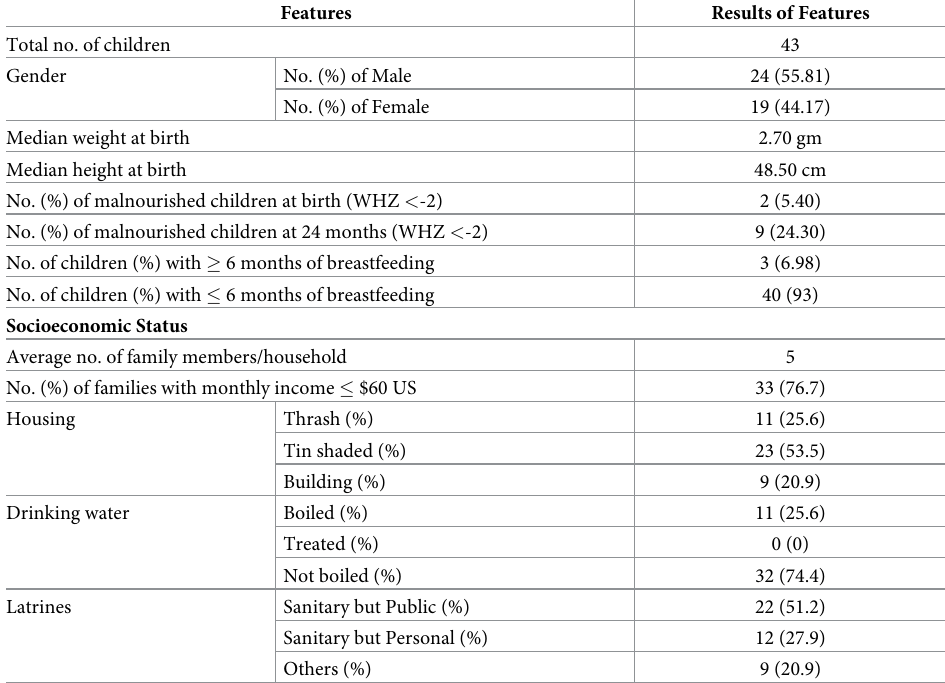
Table 1. Demographic characteristics of the study participants. Features Results of